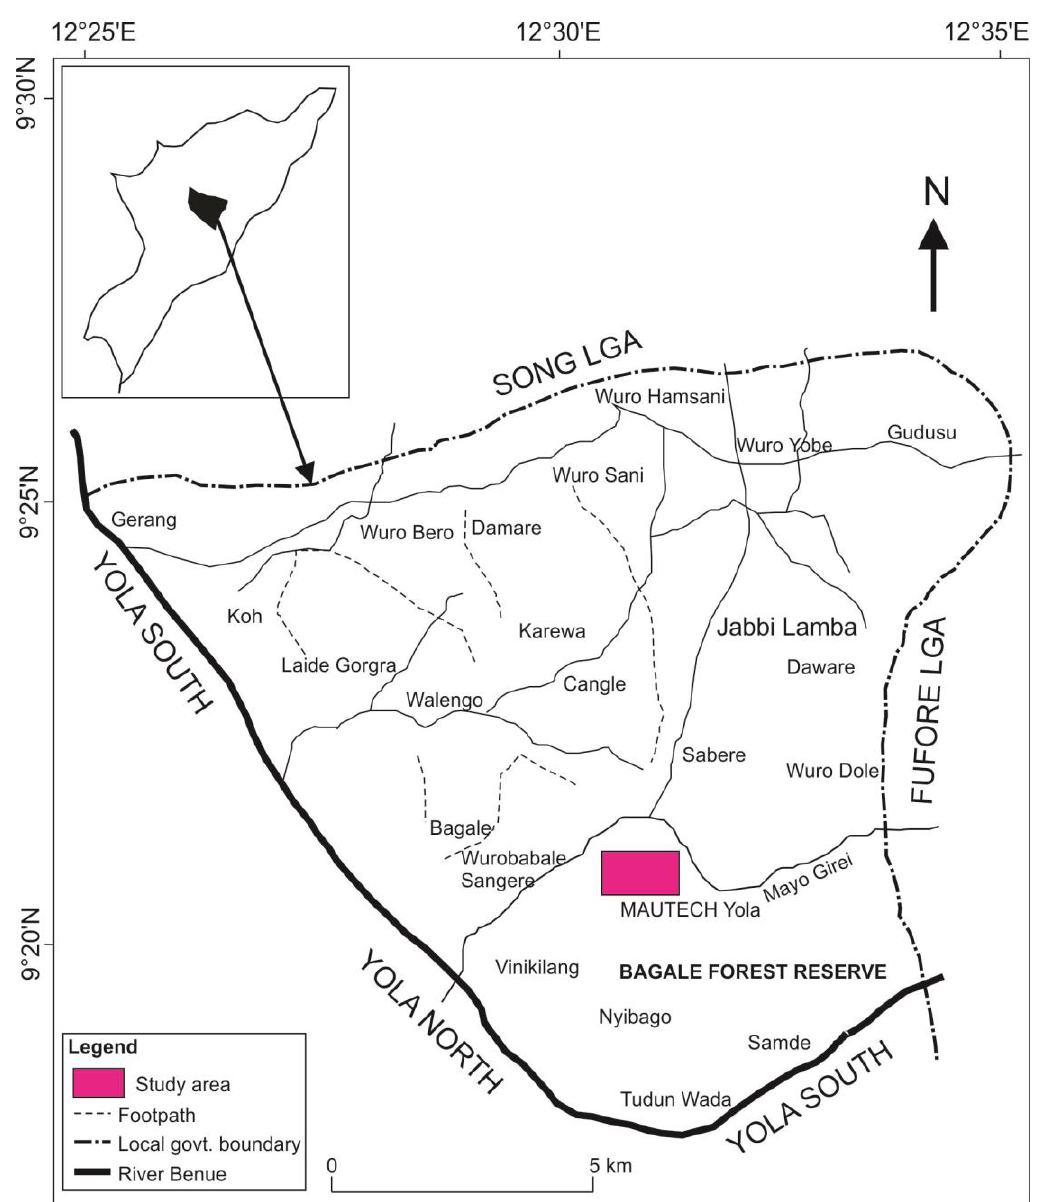
Fig. 1. Map of Girei Local Government Area Showing the Study Area